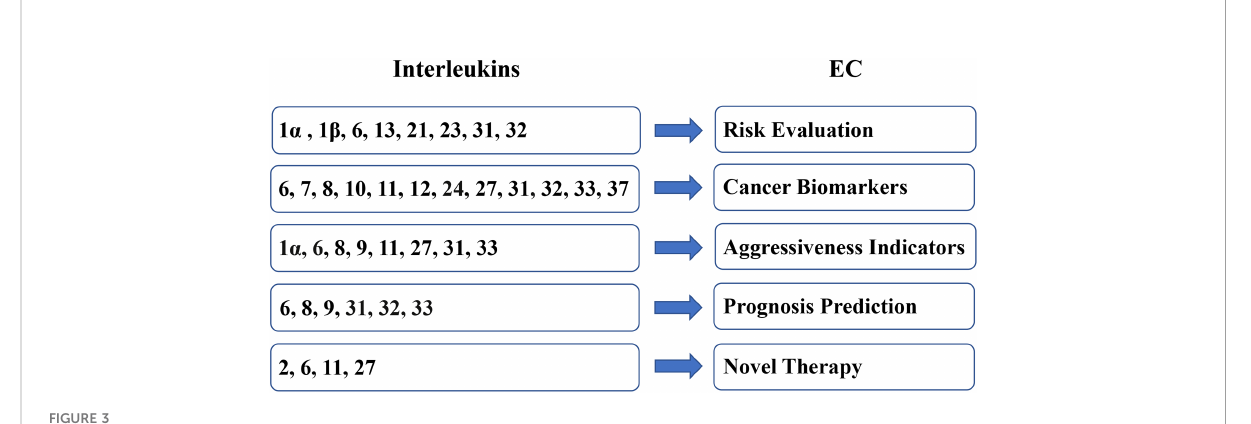
FIGURE 3 Clinical applications of interleukins in